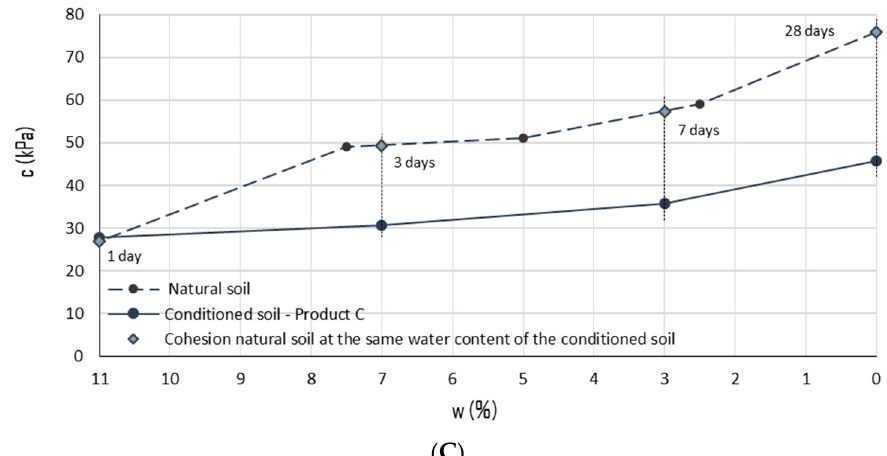
Figure 7. Results of direct shear test for products A, B and C. ( A ) Results of direct shear test for products A—Cohesion; ( B ) Results of direct shear test for products B—Cohesion; ( C ) Results of direct shear test for products C—Cohesion. Table 2. Results of the direct shear test at 45 and 60 days compared to the results at 28 days.